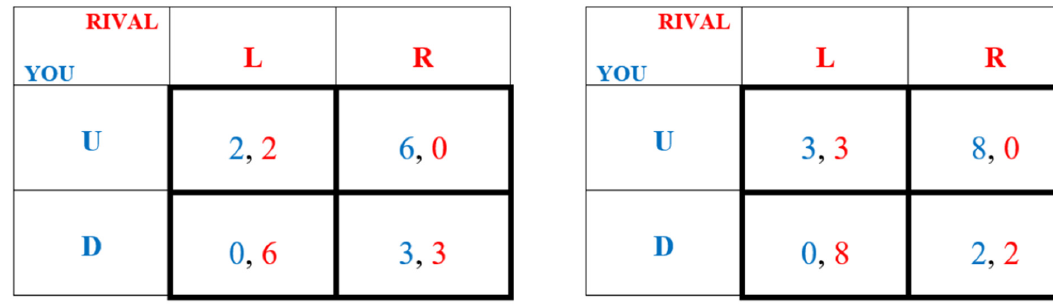
Figure 1. SuA under one best choice.